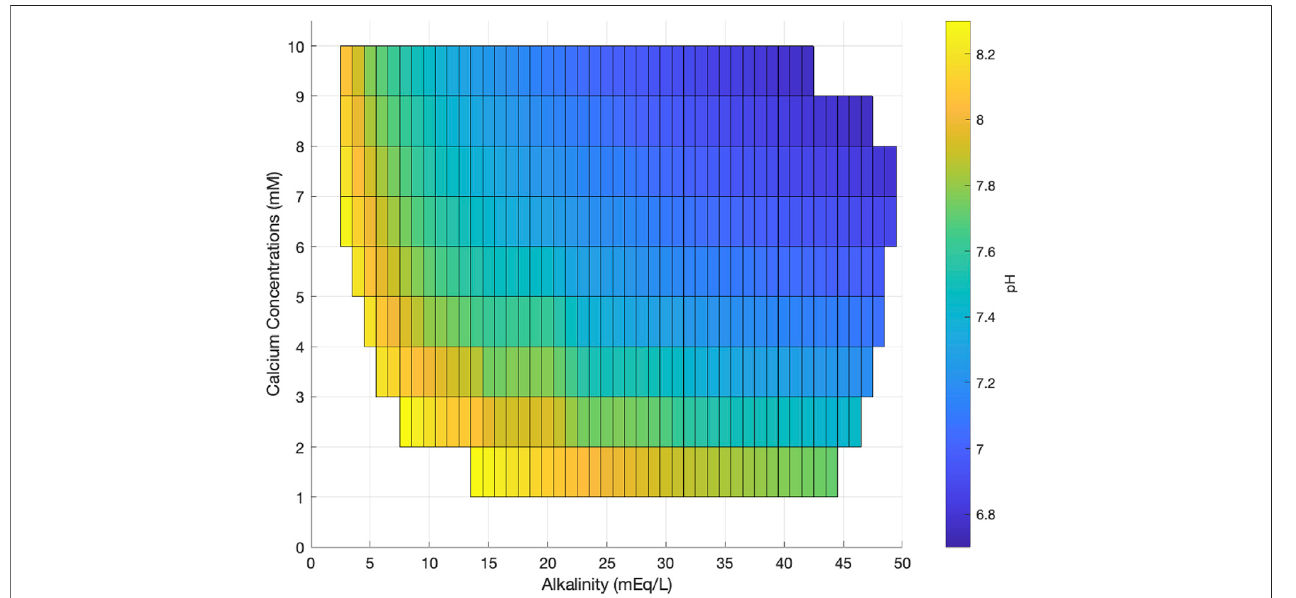
FIGURE 8 | The pH required for calcite saturation (shaded color bar) as a function of the pore fl uid calcium and alkalinity at any given sediment depth.